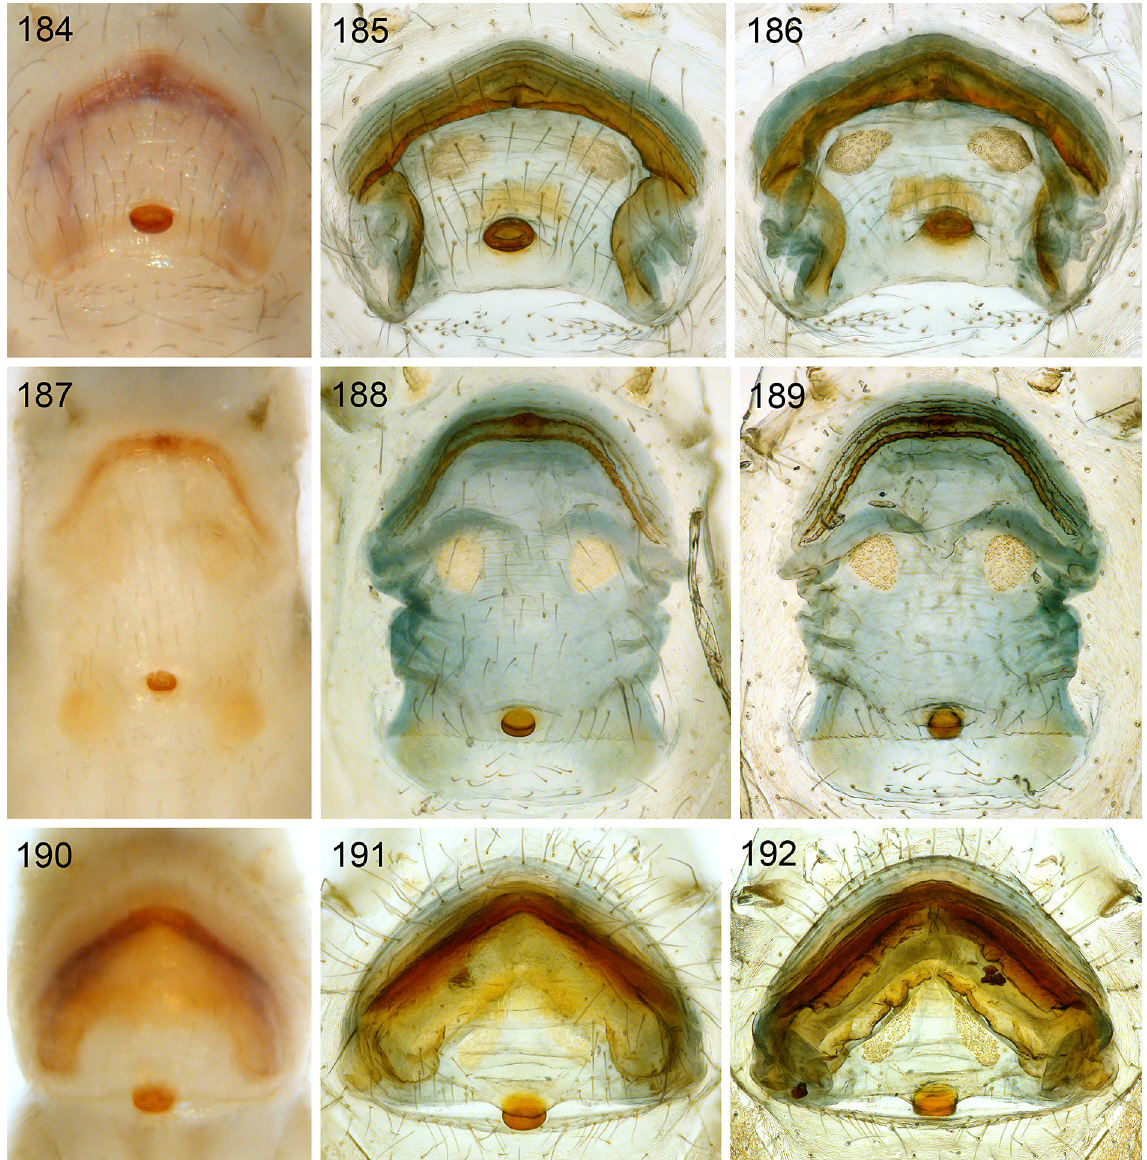
Figs 184–192. Female genitalia, untreated in ventral view, cleared in ventral and dorsal views.